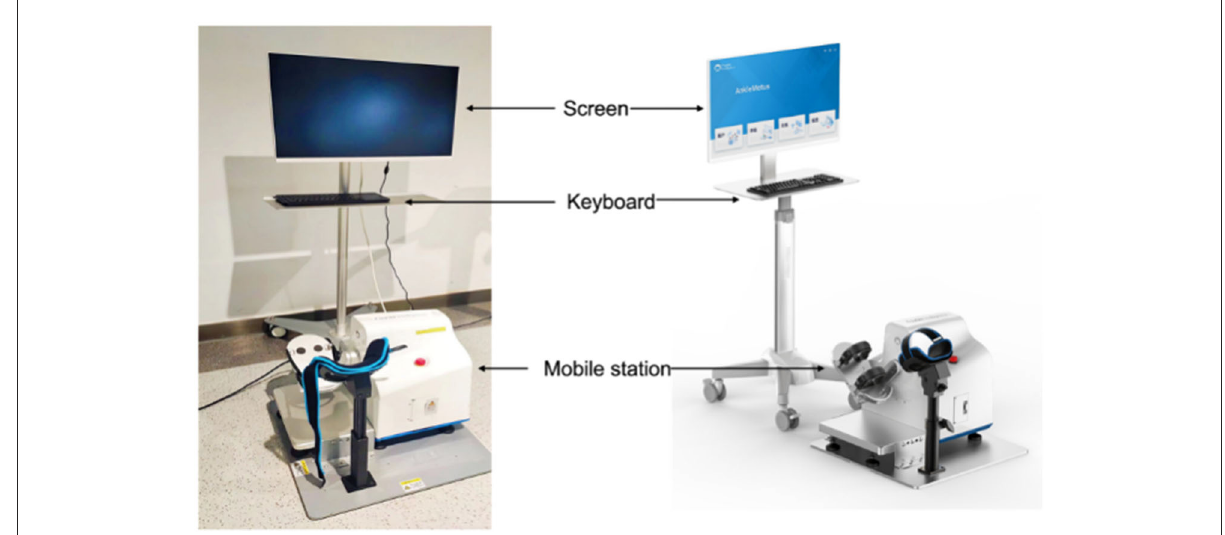
FIGURE2 AnkleMotus M1A.